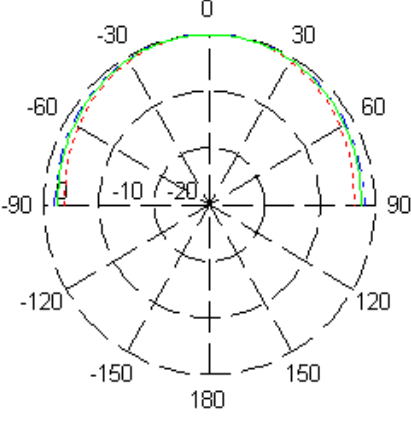
Figure 4. Directivity diagram of CMUT array